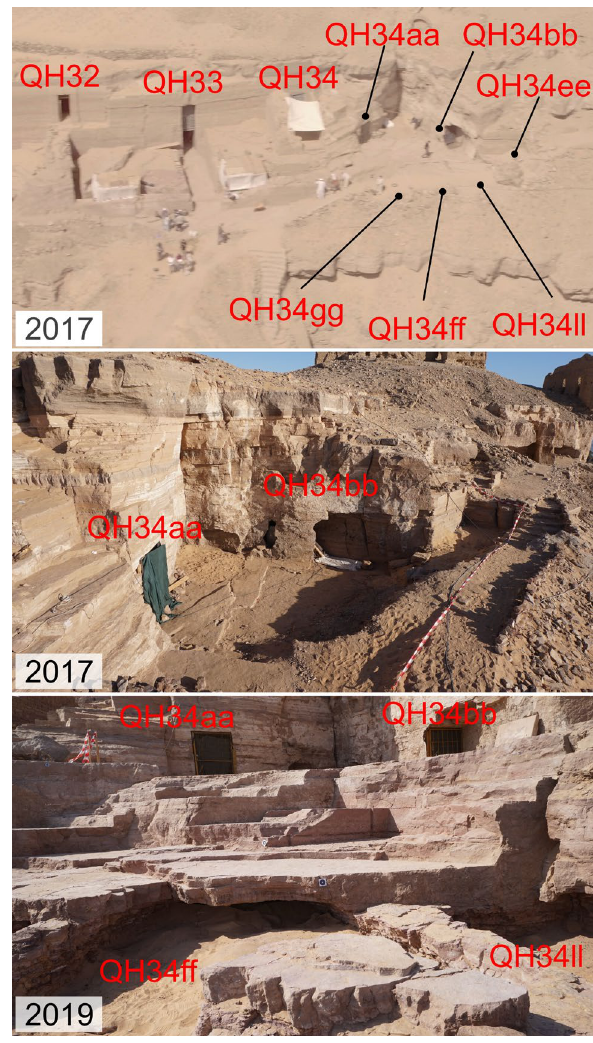
Figure 2. Views of the QH34 zone in 2017 and